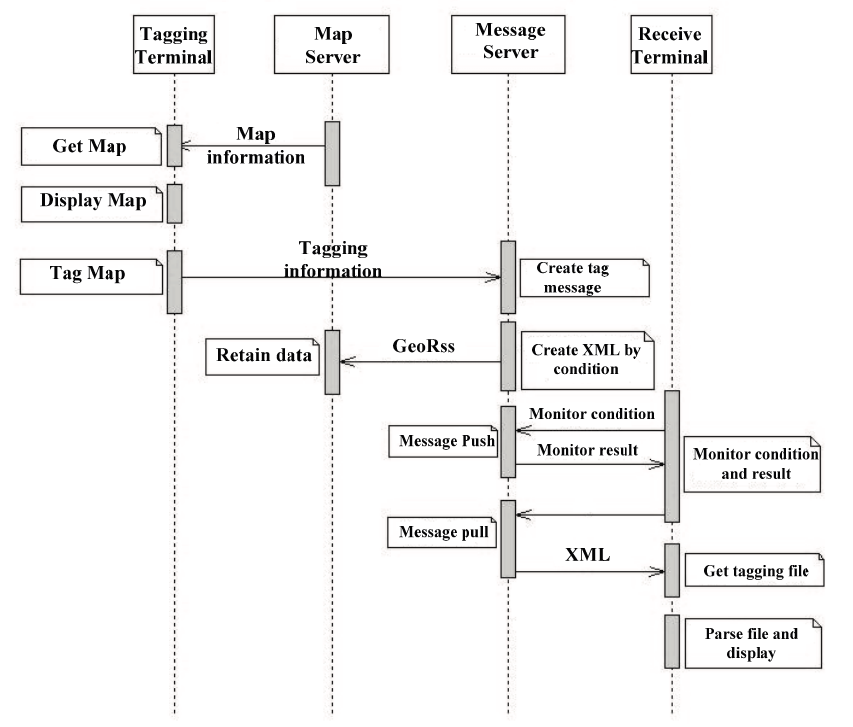
Figure 8. The workflow of borderland information tagging expressed as a UML sequence